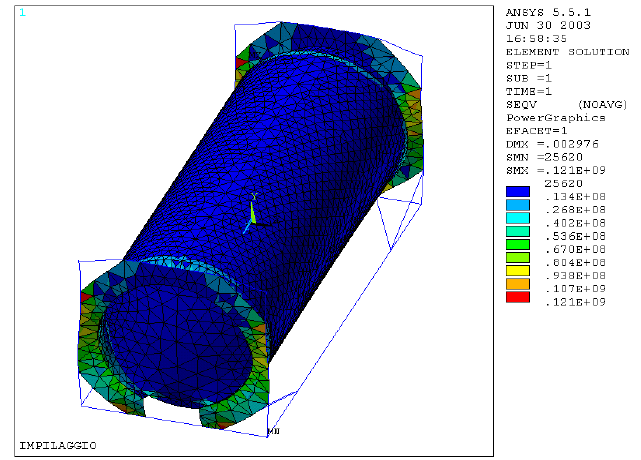
Figure 9. Plot of the maximum equivalent stress for the considered structure.